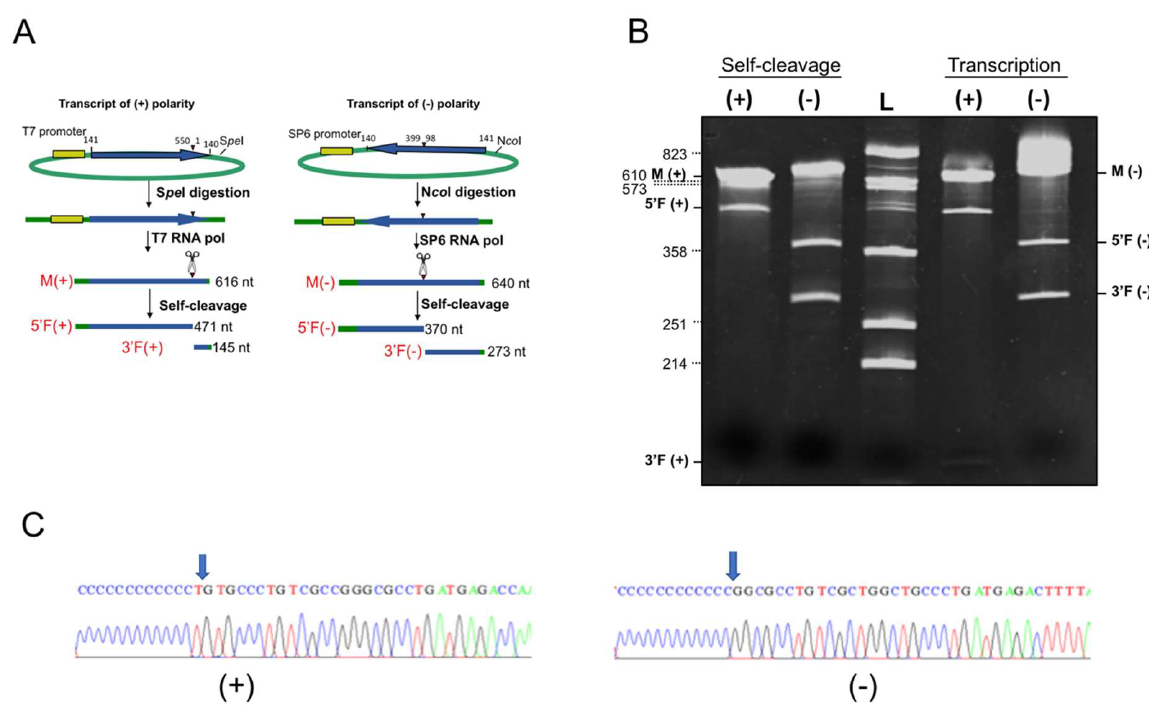
Figure 5. ( A ) Schematic representation of the plasmids and the RNA products generated by in vitro transcription. Plasmids containing the monomeric cDNA sequence of CtaHVd-LR1_3 in opposite orientations were linearized and transcribed to produce monomeric RNAs (M) of (+) and (−) polarity strands and the respective 5′ (5′F) and 3′ (3′F) fragments (left and right, respectively) derived from the HHRz self-cleaving activity. Plasmid sequences are depicted in green, while in yellow and blue are the polymerase promoter and CtaHVd-LR1 sequences, respectively. The scissors and arrowhead mark the position of the self-cleavage sites. The expected size of each fragment is reported on the right. ( B ) Analysis by 5% PAGE under denaturing conditions of the in vitro transcription (left) and self-cleavage reaction in the absence of any protein (right) of the plasmids containing (+) or (−) monomeric CtaHVd-LR1_3 cDNA. L, RNA ladder with sizes indicated on the left; see panel A for the abbreviations M, 3′F and 5′F. ( C ) Determination of self-cleavage site by 5′ RACE of 3′F fragment. Sequencing electropherograms of 5′ RACE products of the (+) and (−) 3′F fragments are shown on the left and right, respectively, with the 5′ terminal nucleotide (G) indicated by the arrow. The extra T observed at the terminal end of the (+) 3′F fragment cDNA (left) correspond to a non-template nucleotide that has likely been added by the reverse transcriptase during the cDNA synthesis [50].